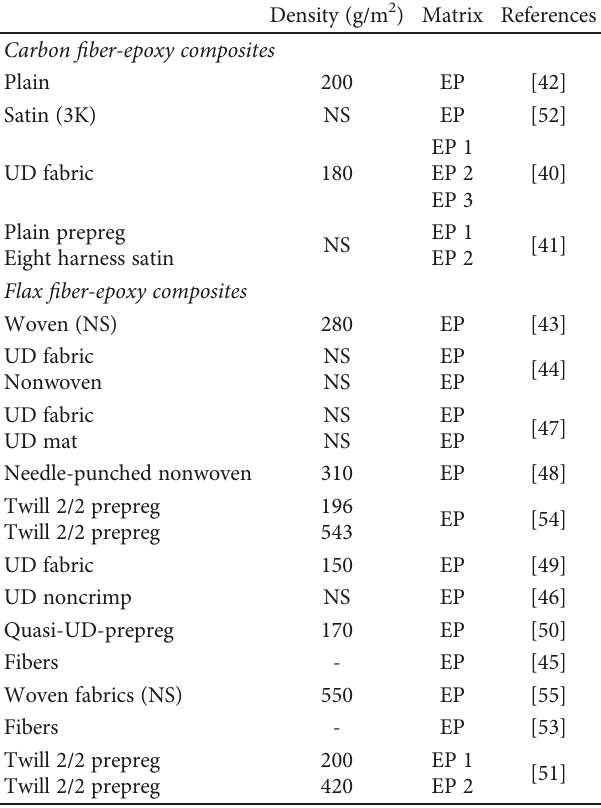
Figure 3: Tensile modulus of carbon-/ fl ax-epoxy and nonhybrid carbon- or fl ax-epoxy composites [9, 12, 13, 17, 19, 21, 23, 25, 26, 40 – 51]. Table 5: Materials used for the manufacture of nonhybrid composites (Figures 2 –